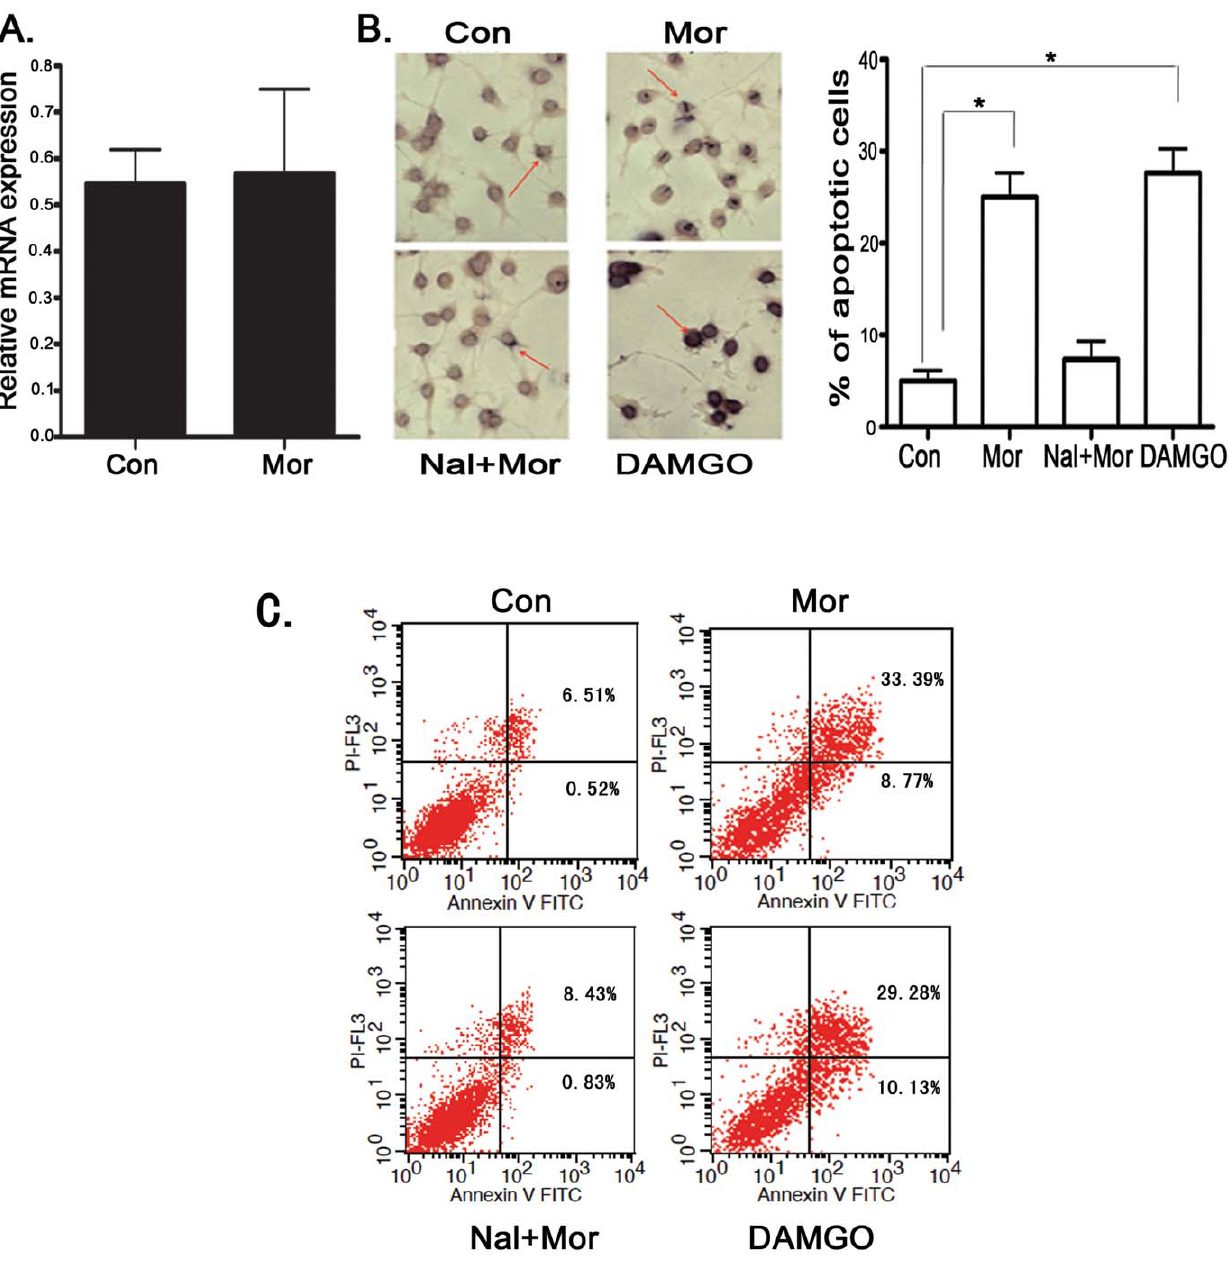
Figure 7. Morphine induces microglia apoptosis in a m OR dependent manner. (A) Morphine could not induce the expression of TLR9 in m OR KO microglia. m OR deficient microglia cells were treated morphine at 10 m M for 12 hr and the expression of TLR9 in mRNA levels determined by quantitative real time RT-PCR as in Fig. 1A. Wild type microglial cells were treated with 10 m M morphine with or without 20 m M naloxone pretreatment. Another group of cells were treated with 10 m M DAMGO alone for 24 hr. Apoptotic cells were examined as in Fig. 3. (B). Representative light microscopic images showed TUNEL-positive microglia (red arrow head). Magnification 200 6 . Results represent mean 6 SD from three independent experiments. * p , 0.01 compared with indicated groups. (C). Apoptotic cells were analyzed by flow cytometry. These results are representative of three independent experiments.